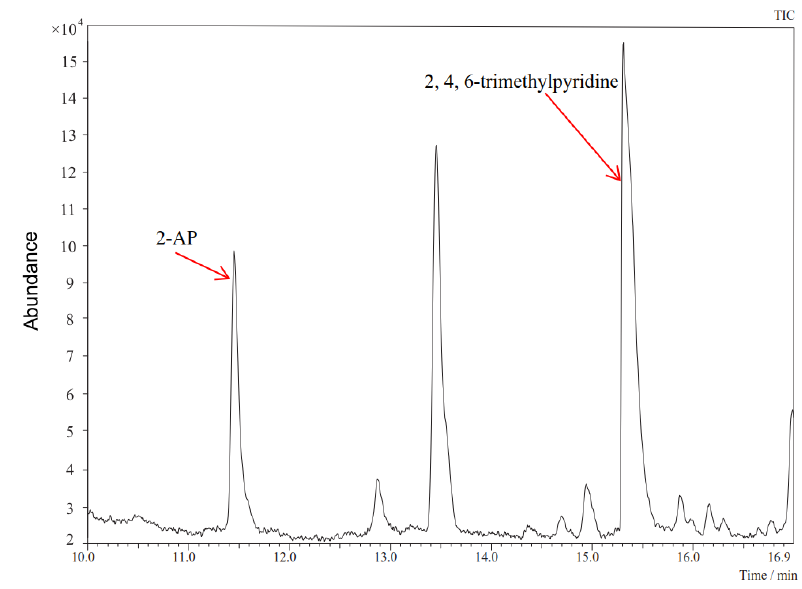
Figure 3. 2-AP quantitative chromatogram.